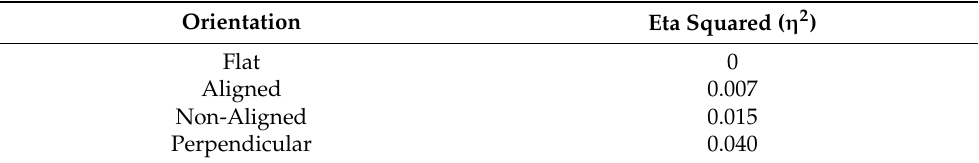
Table 1. Eta squared ( η 2 ) of the intensity of BDNF between non-stimulated and stimulated cells on different fiber orientations. Perpendicular fibers appear to exert the largest effect compared to other orientations. However, a value of 0.040 suggests a small (0.01) to medium (0.06) effect on BDNF intensity.